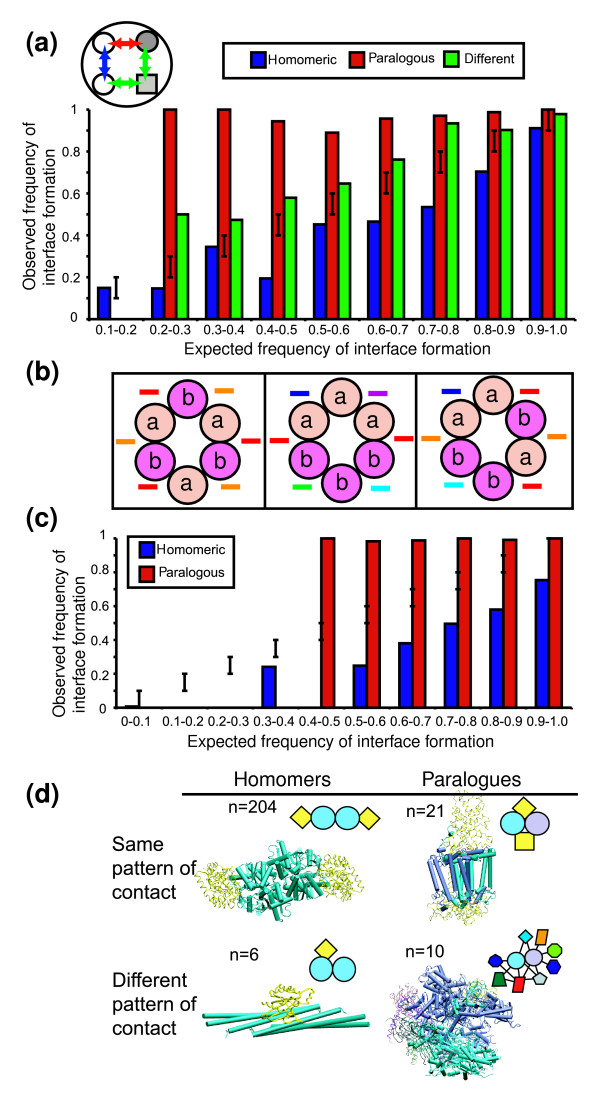
Duplicated subunits in complexes interact. (a) Interactions between paralogous subunits (red) are more frequent than expected given the stoichiometry of subunits within protein complexes. Chains from PQS complexes were binned according to probability of forming a homomeric interaction or interactions between paralogous or different chains (see Materials and methods). The frequencies at which these chains form homodimers and paralogous dimers (averaged for each bin) are shown as blue and red bars, respectively. In a random scenario, all the points lie within the range shown in the black lines. (b) Possible arrangements of two distinct subunits in a hexameric ring like that of the F1 complex. The actual F1 complex is shown on the left. Bars of different colors correspond to different inter-subunit interfaces. (c) If there are multiple identical and paralogous chains within a protein complex, the chains tend to be arranged in three-dimensional space so that the paralogous chains rather than identical chains are contacting each other, corresponding to the scenario shown on the left. Note that when there is a choice, interactions between paralogous proteins are always preferred. This experiment is similar to that described in (a), but considering only the two types of interaction in the calculations. (d) The role of oligomers of paralogues in generating structural diversity. n is the number of protein complexes found in PQS that have identical chains (left) or paralogous chains (right), which contact the same (top) or distinct binding partners (bottom). Hetero-oligomers that contain paralogous dimers are more frequently asymmetrical (10/31) than those containing homomers (6/210), that is, paralogues tend to bind different partners. The complexes shown illustrate the four possible situations. Top left is the tryptophan synthase from Salmonella typhimurium, in which the homomeric α:α dimer (blue) binds one β subunit on each side (yellow) [50], which represents symmetry in binding partners of homomers. Top right is the photosynthetic reaction centre from Rhodopseudomonas viridis, in which both paralogous L and M chains (blue and purple) bind to the H and C subunits (shown in yellow) [51], which illustrates symmetry in the binding partners of a dimer of paralogues. Bottom left is the structure of the Rac1 small GTPase bound to the arfaptin-1 homodimer [52] from Homo sapiens, in which Rac1 binds solely one of the arfaptin chains, but occupies a volume that excludes the possibility of additional Rab molecules binding the other arfaptin chain; this illustrates the rare cases of asymmetry in the binding partners of homomers. Bottom right is the RNA polymerase from S. cerevisiae [53], in which many peripheral subunits decorate the central core formed by the dimer of paralogues A:B, which illustrates the creation of asymmetry by the duplication of the ancestral homodimer [32].